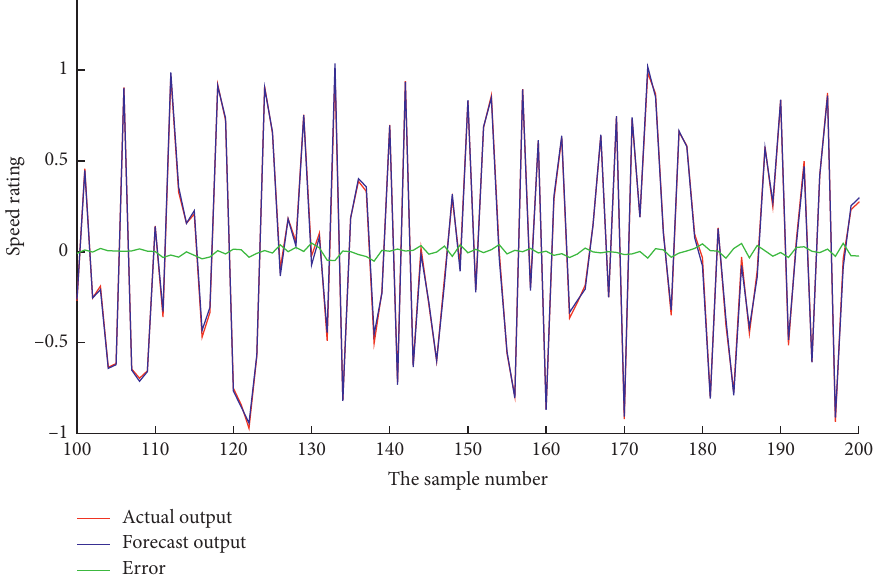
Figure 9: Improved T-S fuzzy neural-network training data prediction local chart.